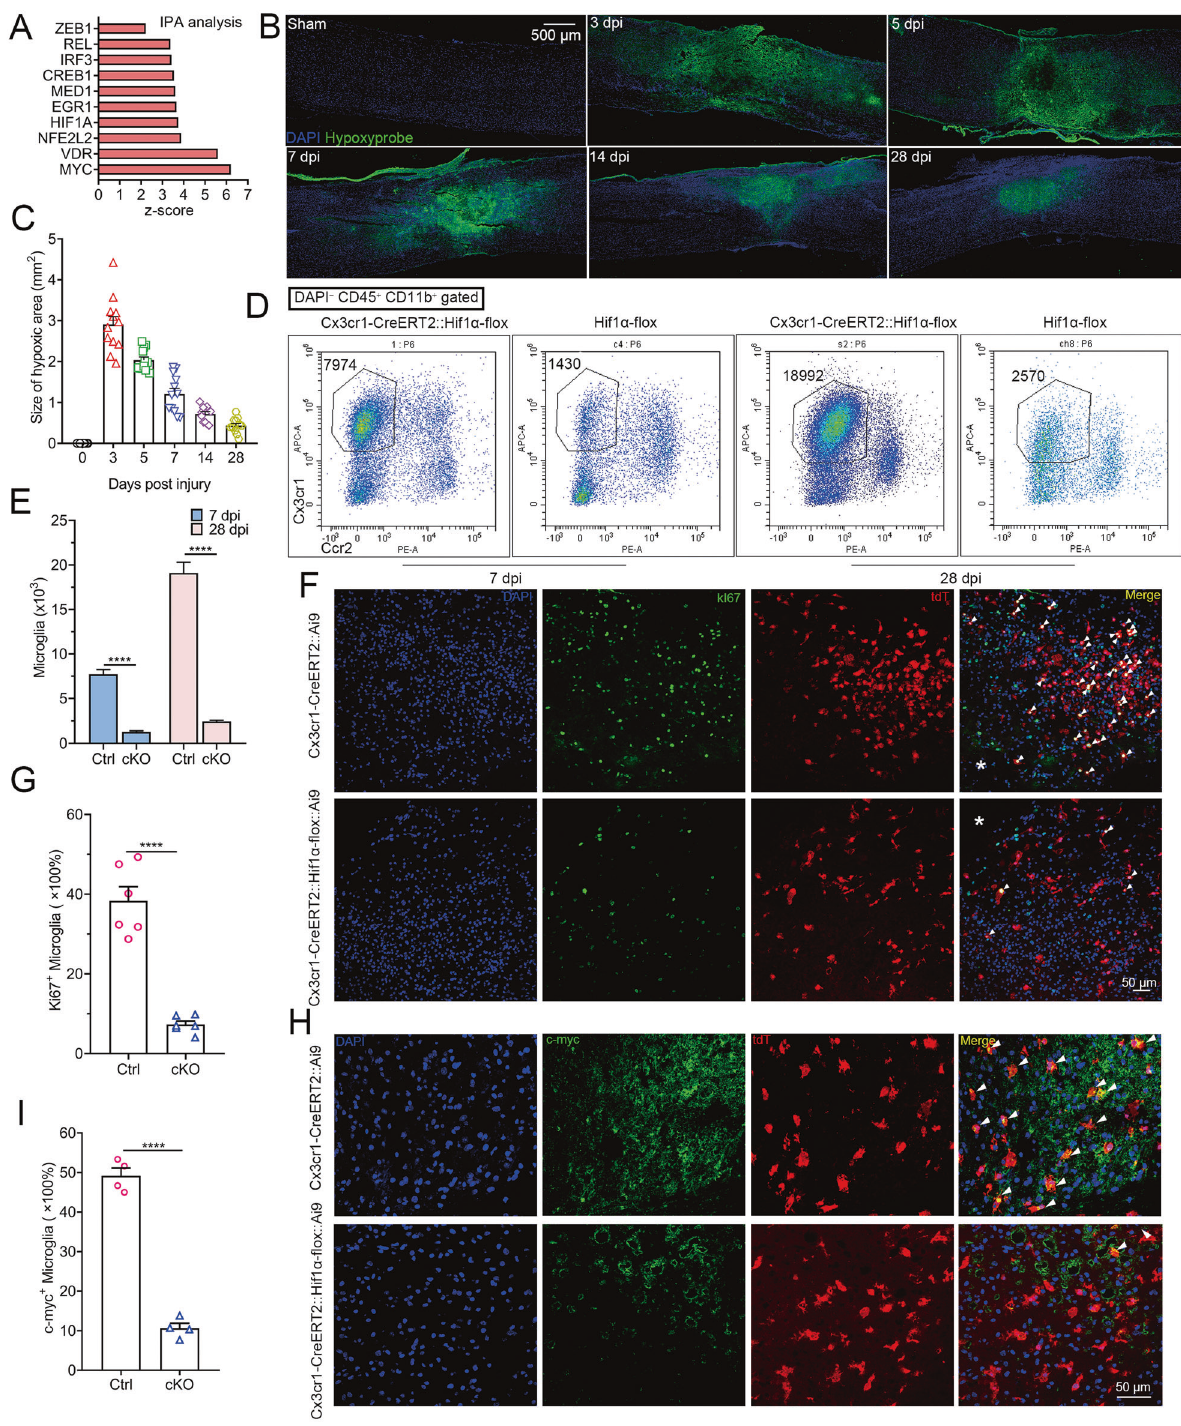
Fig. 5 Hif1 α promotes the proliferation and repopulation of microglia after SCI by maintaining their stemness. A Ingenuity Pathway Analysis showing the upstream regulatory factors for DEGs in PaMG1 compared to hMG. B IHC images reveal hypoxic conditions in the lesion sites (pimonidazole binding area) after SCI. C Statistical histogram of B , n = 12 sections from four independent mice per group. D Flow cytometric analyses showing the absolute number of microglia in Hif1 α cKO mice and control mice after SCI at 7 and 28 dpi. Ccr2 was used to exclude monocyte-derived cells. E Statistical histogram of D . n = 6 independent mice per group, multiple unpaired two-tailed Student ’ s t -test, ****P < 0.0001. F IHC images showing proliferative microglia (Ki67 + tdT + cells) at 3 dpi. Scale bar: 50 μ m. G Statistical histogram for F . n = 6 independent mice per group, unpaired two-tailed Student ’ s t -test, ****P < 0.0001. H IHC images show the expression of c-myc in microglia (tdT + cells) at 3 dpi. Scale bar: 50 μ m. I Statistical histogram of H . n = 4 independent mice per group, unpaired two-tailed Student ’ s t -test, ****P <